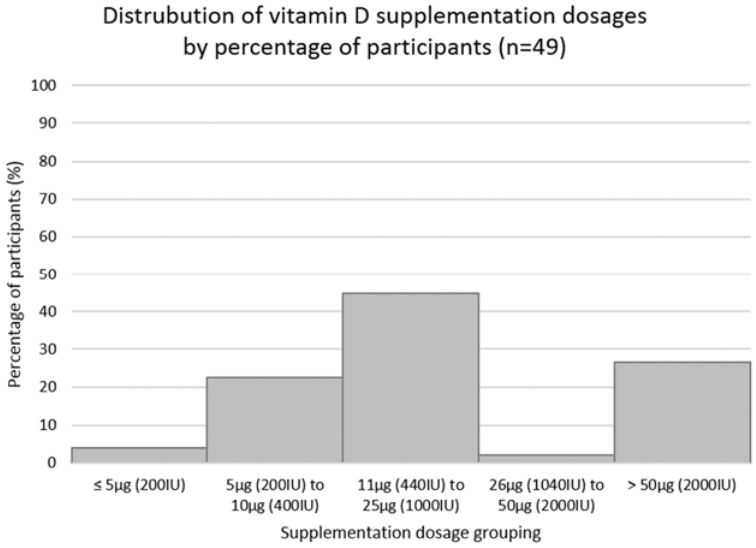
Figure 4. The distribution of vitamin D supplementation dosage by dosage groupings of the participants taking supplements and who know their dosage ( n = 49). Abbreviations: Percentage (%); International Units (IU); micrograms ( μ g). Table 5. Factors contributing to vitamin D supplementation use. A logistic regression predicting likelihood of supplement use on relevant factors ( n = 208, one participant did not respond).